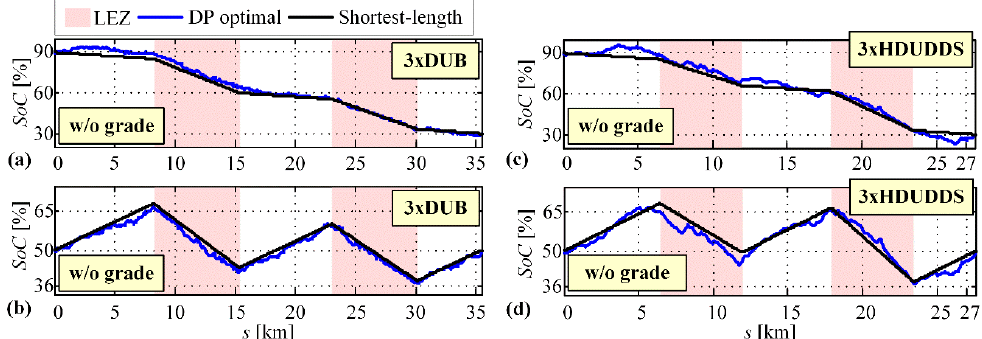
Figure 8. ( a , c ) Optimal SoC trajectories and corresponding shortest-length (piecewise linear) trajectories in case of LEZ presence, for SoC i = 90%, SoC f = 30% and ( b , d ) SoC i = 50%, SoC f = 50% and for 3xDUB, 3xHDUDDS driving cycles and zero road grade.